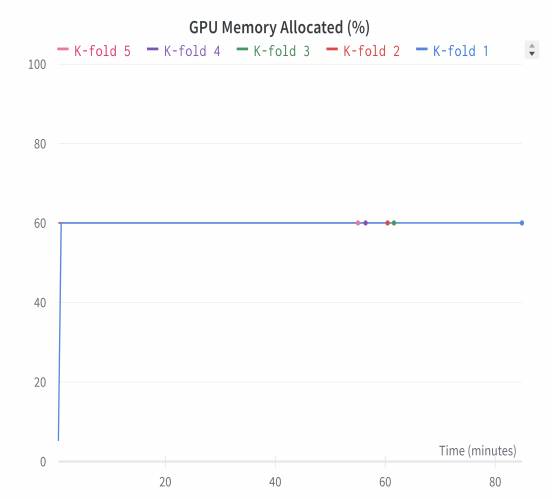
Figure 15. GPU Memory Allocated percentage graph for InceptionV3 model.